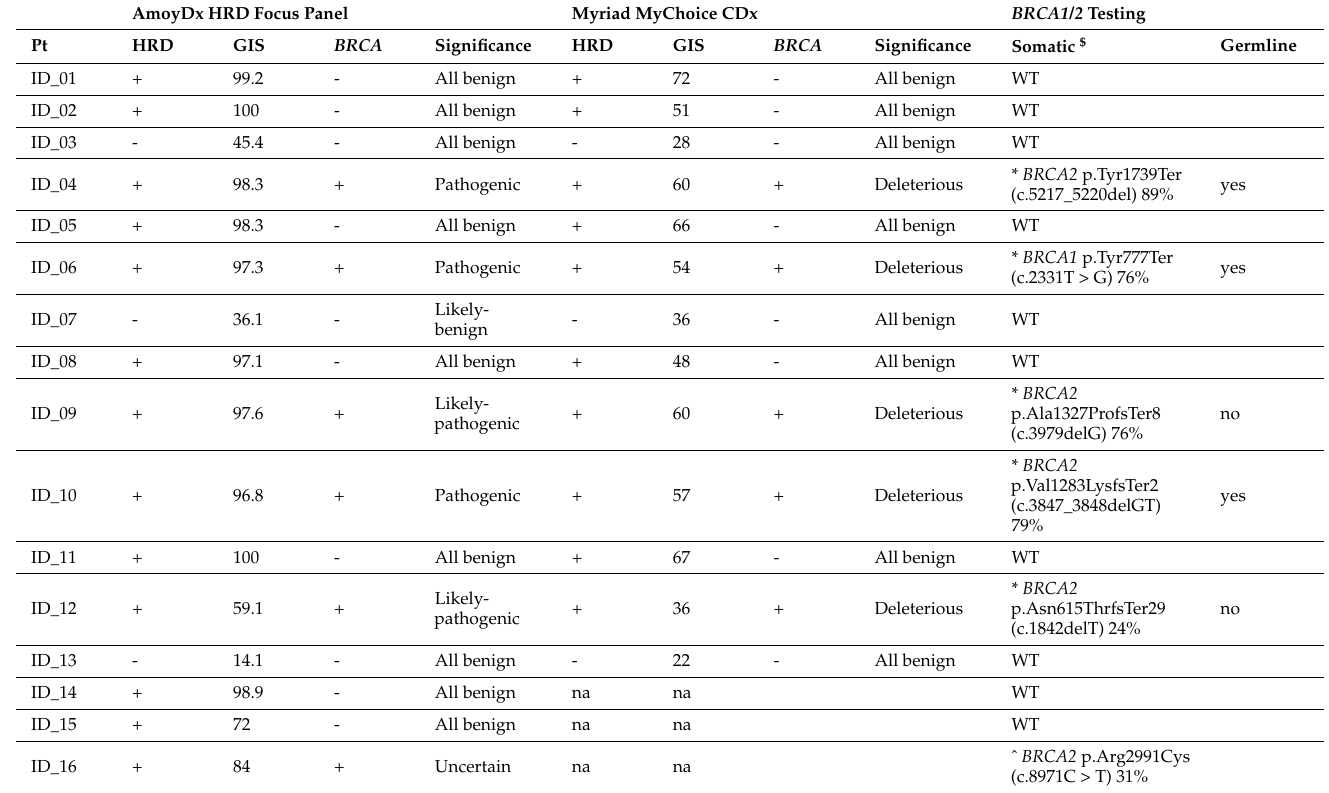
Table 2. Results of AmoyDx HRD Focus Panel (left), Myriad MyChioce CDx (central), and BRCA somatic and germline tests (right).